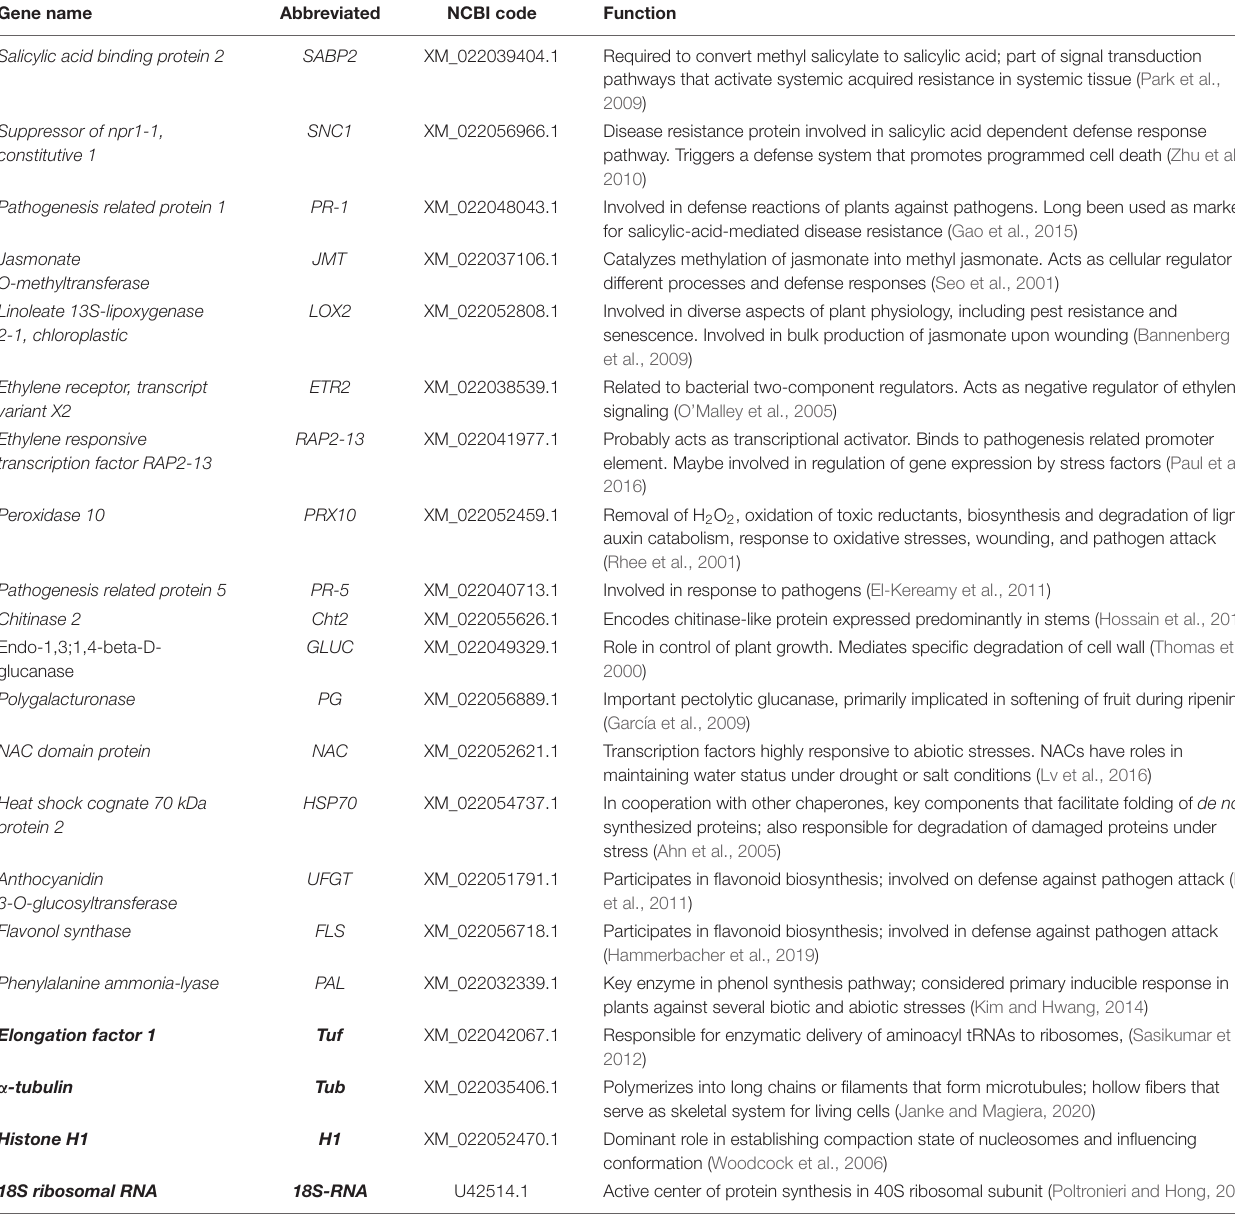
TABLE 1 | Genes selected for gene expression.